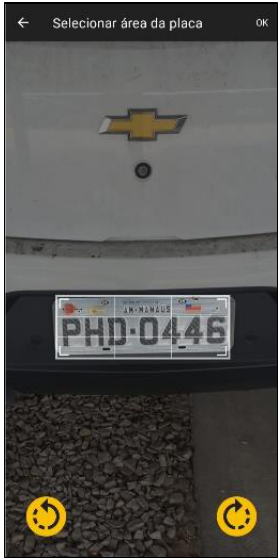
Figure 12: Vehicle License Plate Area Cutout Screen.